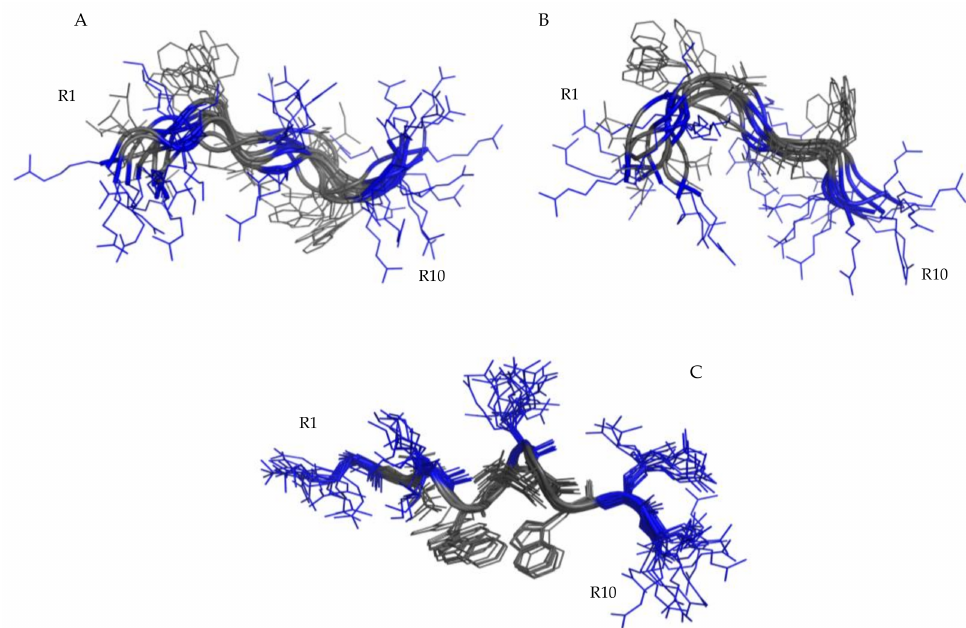
Figure 5. NMR structures of RiLK1. Superimposition of structures belonging to the first two Chimera clusters representative of RiLK1 conformation in water: ( A ) cluster 0, 9 models; ( B ) cluster 1, 8 models; ( C ) superimposition of 20 structures belonging to the main Chimera cluster representative of RiLK1 conformation in SDS. Cartoon representation with hydrophobic side-chains as lines colored in gray and positive charged ( R , K ) in blue.